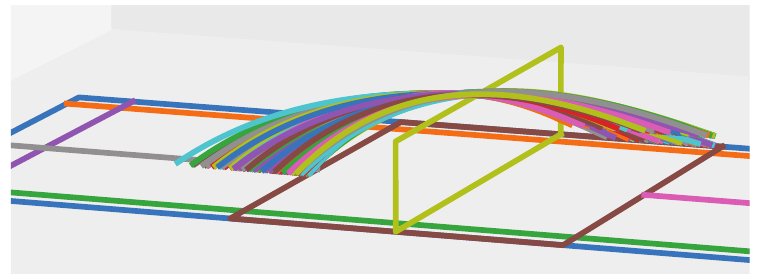
Figure 5. The 190 excellent serves better than 2% of the average according to